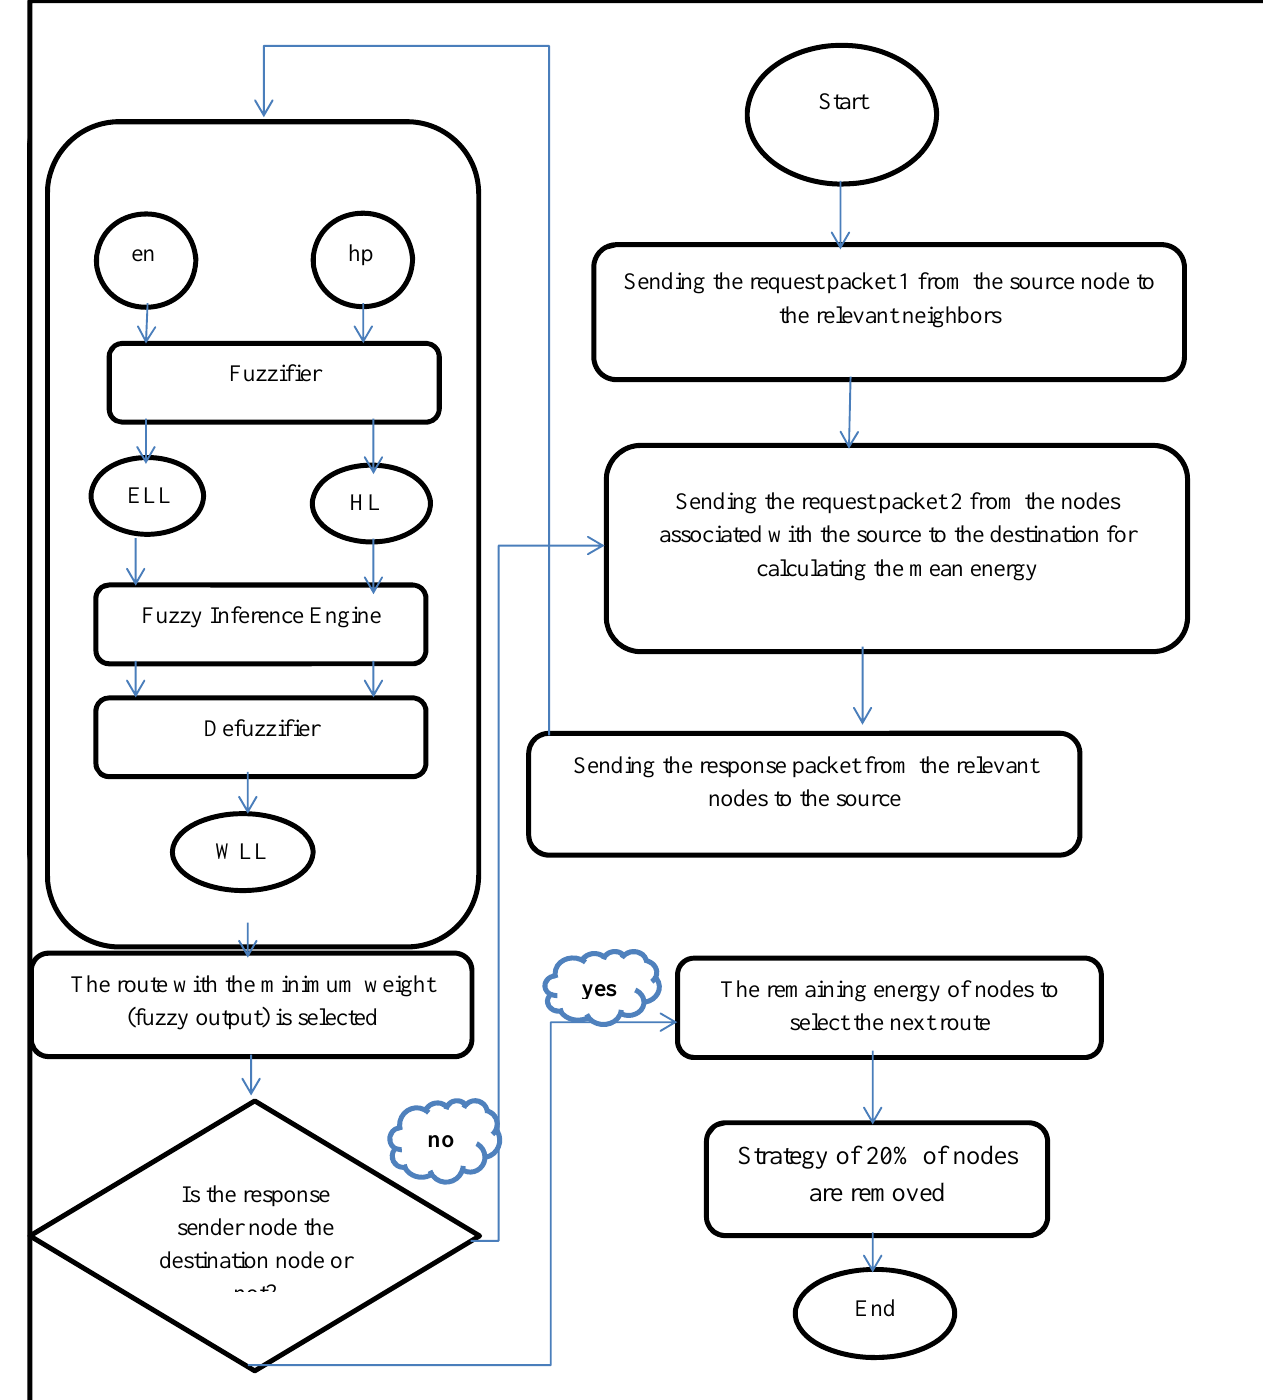
Fig. 1. Flowchart of proposed